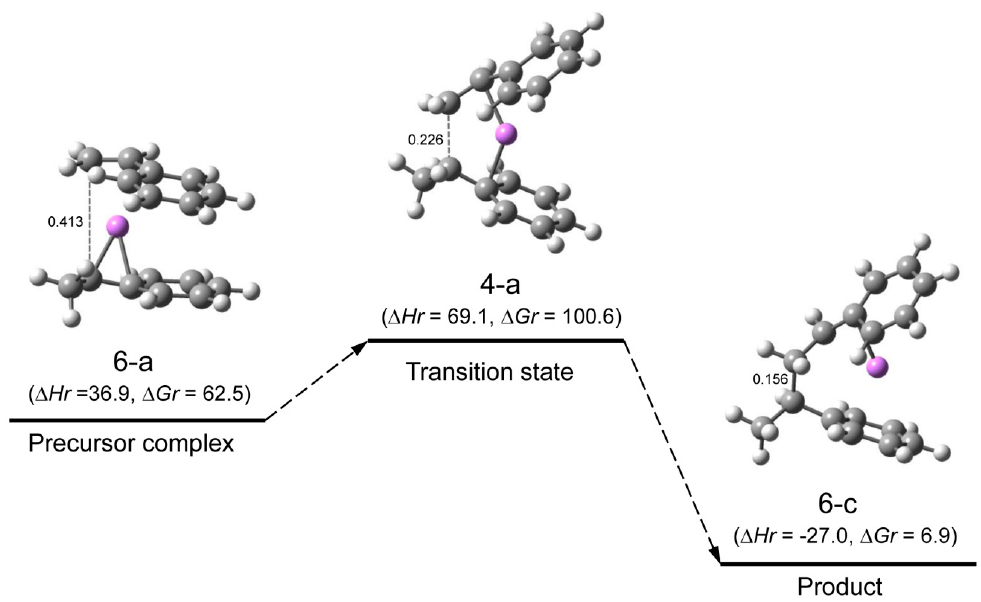
Figure 6. Reaction pathway for system(s-4-a) (St/[HStLi(2-a)]) in the gas phase. ∆ Hr and ∆ Gr , the relative enthalpy and relative free energy, are expressed in kJ·mol –1 . Numerical values in the drawings as in Figure 5.